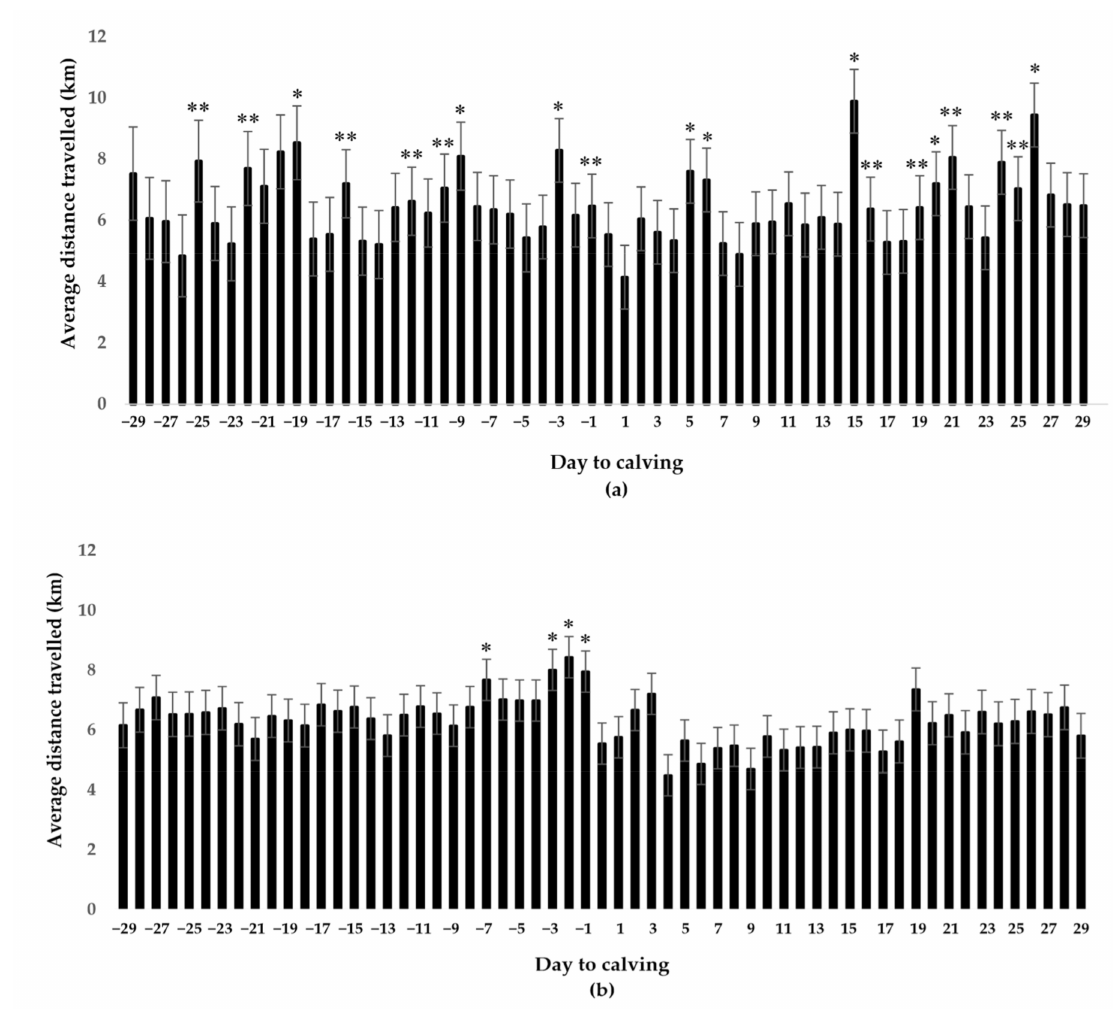
Figure 2. Average distance travelled per day by collared cows 30 days each side of the calving date in Trial 1 ( a ) and 2 ( b ). Means with an Asterix (*) indicate a significant di ff erence from the day of calving ( p < 0.05). Means with two Asterix (**) indicate a significant di ff erence from day 1 ( p < 0.05). Only collared cows with a confirmed calving date ( n = 8 in Trial 1 and n = 7 in Trial 2) were